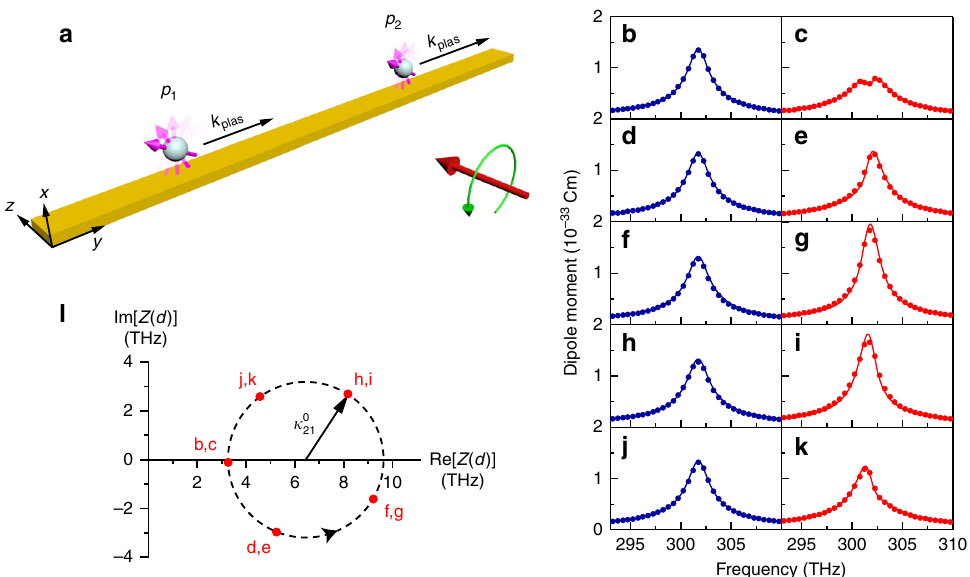
Fig. 2 Exceptional point in the model system with unidirectional coupling . a In the limit of Δ γ → 0, the coupling from p 2 to p 1 is suppressed by the waveguide ’ s loss. The model system reduces to the effective system where two resonators are unidirectionally coupled through a straight waveguide. b – k Evolution of the electric dipole moments p 1 (left column) and p 2 (right column) under left-handed circular polarisation excitation for d = 2.0 λ plas ( b , c ), 2.2 λ plas ( d , e ), 2.4 λ plas ( f , g ), 2.6 λ plas ( h , i ) and 2.8 λ plas ( j , k ). The symbols denote the simulation results and the solid lines denote the fi tting results of coupled mode theory. l Evolution of Z ( d ) = Γ /2 − i κ 21 ( d ) on the complex plane when d varies. The red symbols (labelled by panel numbers) correspond to the fi tting results in ( b – k